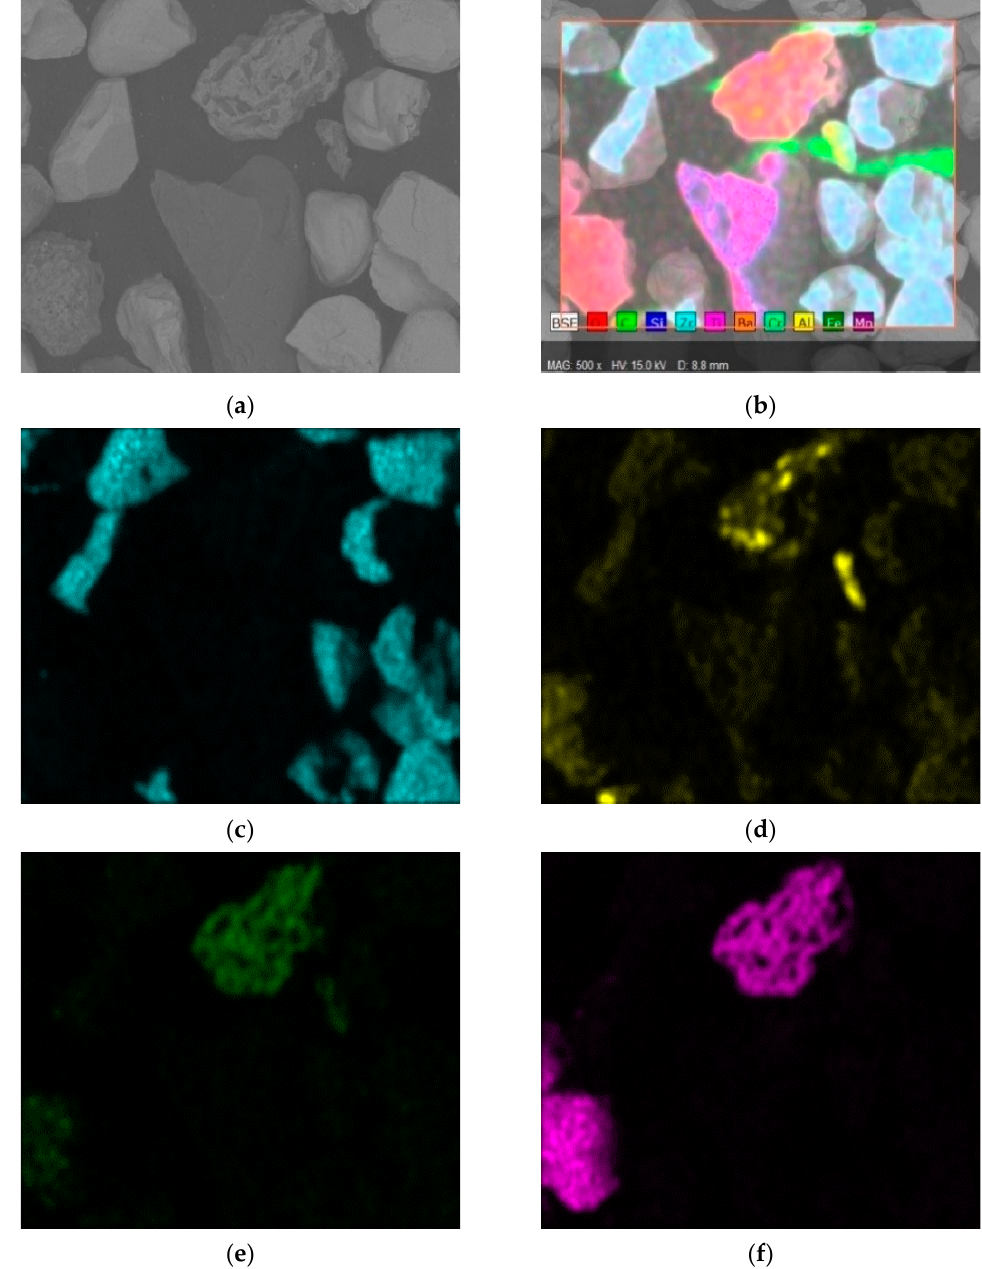
Figure 12. Distribution of the elements: ( a ) fraction 5; ( b ) distribution of elements on the surface; ( c ) zirconium; ( d ) aluminum; ( e ) iron; ( f ) titanium.